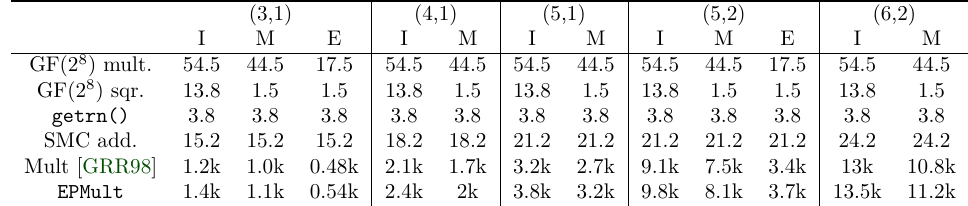
Table 8: Execution time for GF(2 8 ) and SMC operations in µ s with the CPU running at 4 MHz. I:Instruction Only, M:Mixed, E: